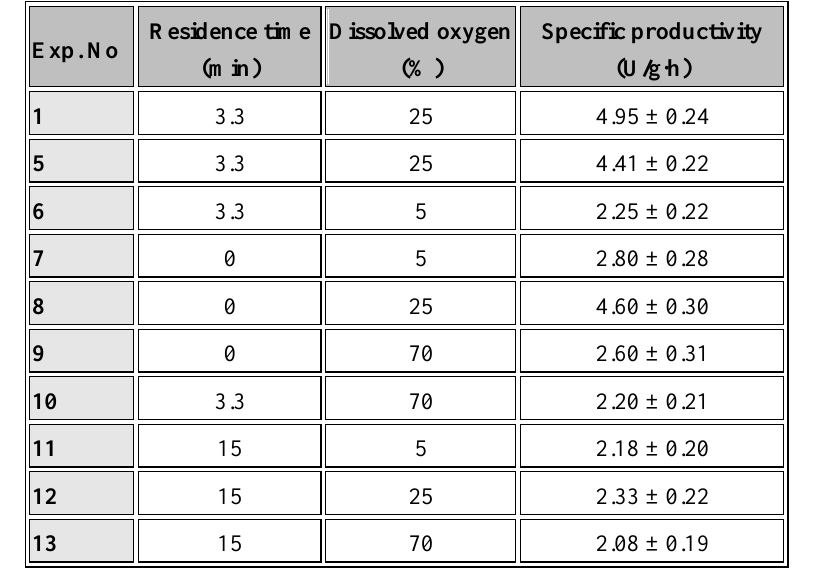
Table A2. The response to be modeled (value and standard deviation) for DoE